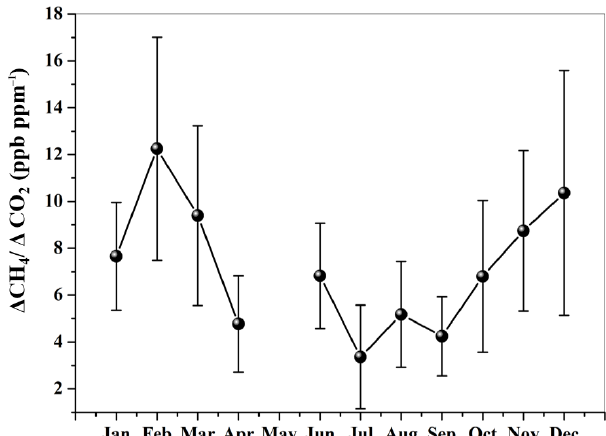
Figure 4. Monthly variation of (cid:49) CH 4 /(cid:49) CO 2 during the study pe-